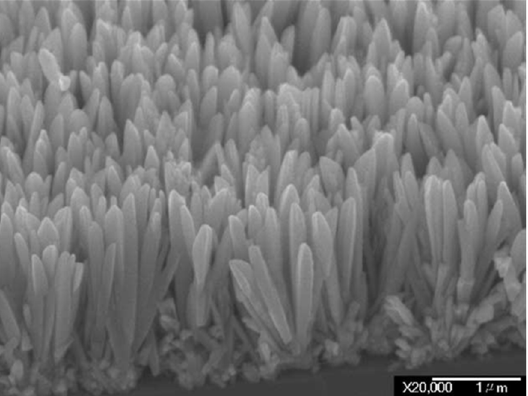
Figure 11. Field-Emission Scanning Electron Microscopy images of the IrO 2 nanorods fabricated with this method (Reprinted/adapted with permission from Ref. [5]).